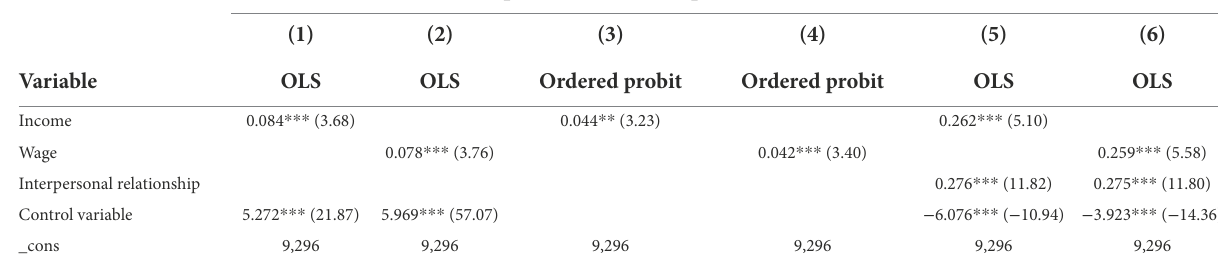
TABLE 9 With interpersonal relationship as a mediating